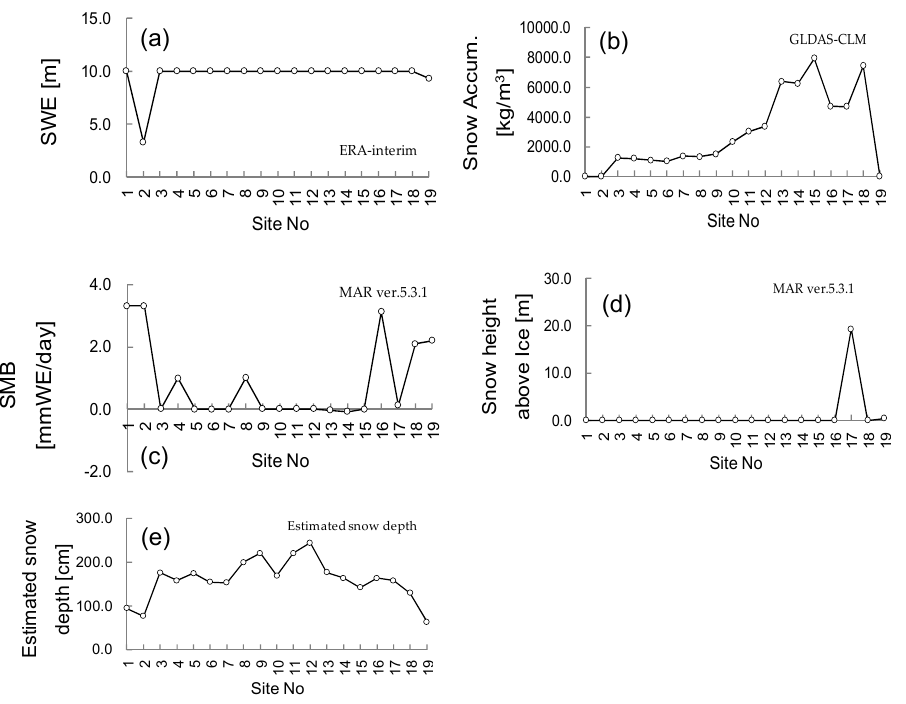
Figure 14. Output of ( a ) the daily surface snow water equivalent (SWE; m) from ERA-interim, ( b ) the daily surface accumulation of snow (kg/m 2 ) from GLDAS-CLM, ( c ) the daily surface mass balance (SMB, mm WE/day; WE = water equivalent) from MAR ver. 5.3.1 based on NCEPv1, ( d ) snowpack height above ice (m) from MAR, and ( e ) estimated snow depth (cm) from this study at 19 in situ observation sites.